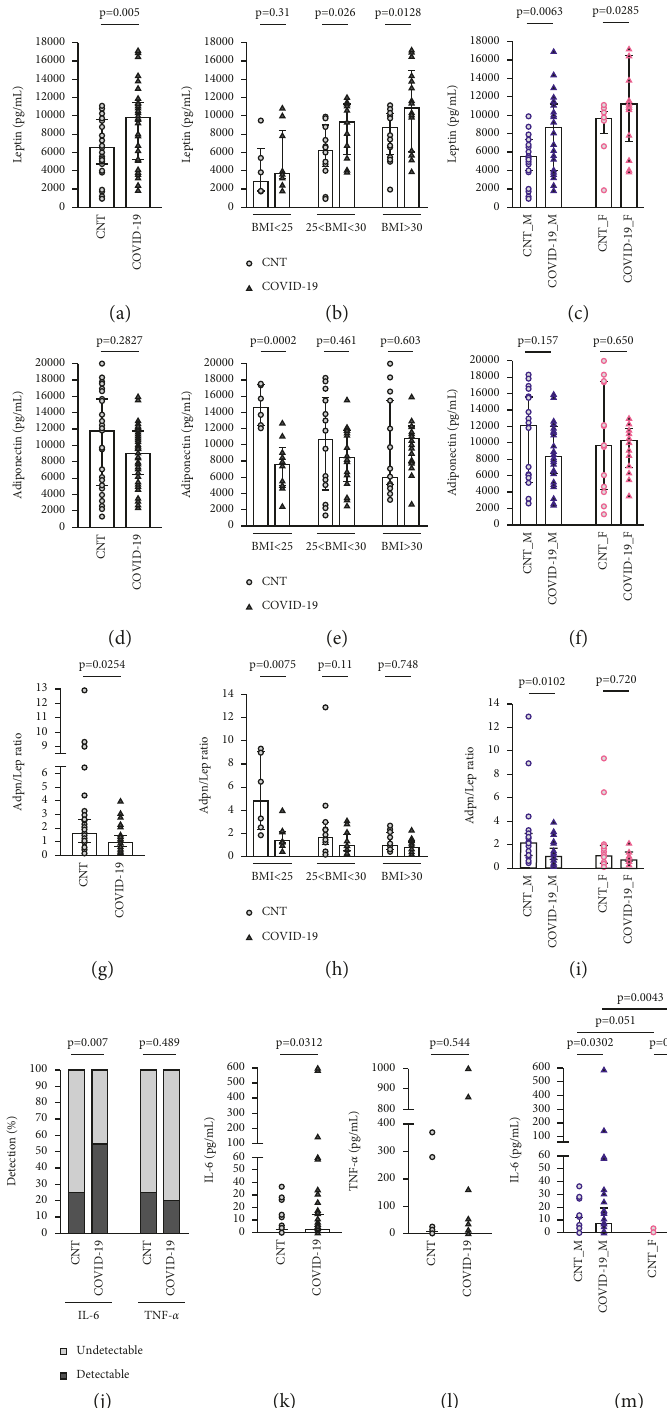
Figure 1: Leptin, adiponectin, Adpn/Lep levels, IL-6, and TNF- α in patients with COVID-19 pneumonia (COVID-19) and healthy controls (CNT). (a) Leptin, Mann–Whitney test. (b-c) Leptin after BMI and sex stratification, Mann–Whitney test or unpaired t-test. (d) Adi- ponectin, t -test. (e-f) Adiponectin after BMI and sex stratification, t -test. (g) Adpn/Lep, Mann–Whitney test. (h-i) Adpn/Lep after BMI and sex stratification, Mann–Whitney test. (j) Percentage of patients with detectable levels of IL-6 and TNF- α , chi-square test. (k)